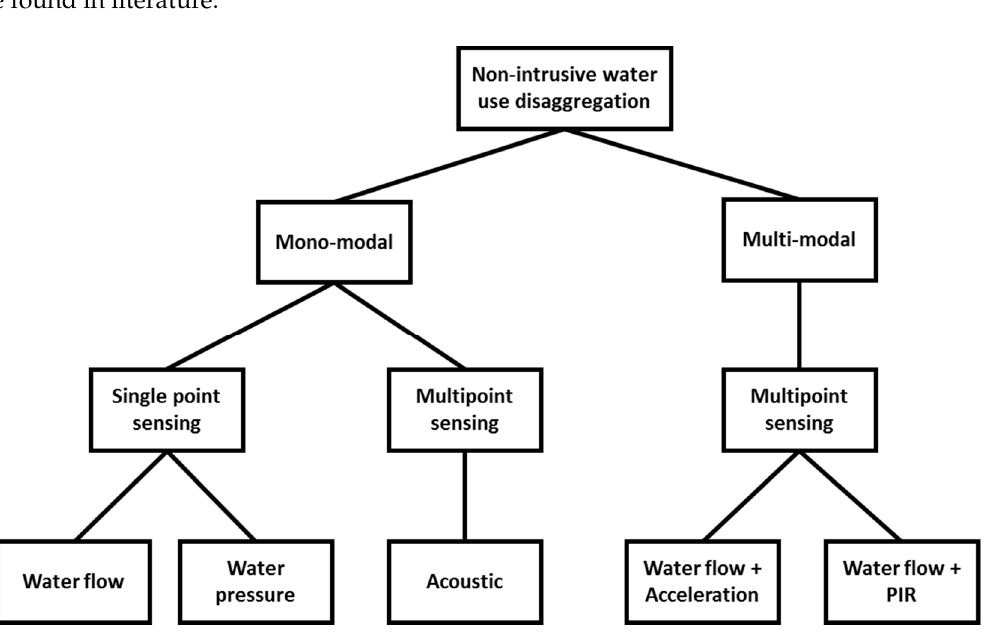
Figure 1. Overview of the different sensing modalities for water disaggregation (PIR stands for Passive Infra-Red).